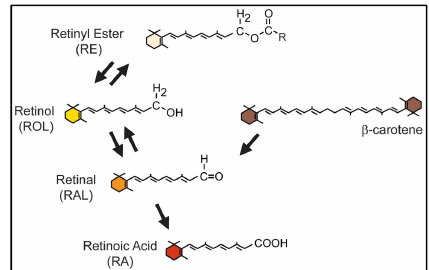
Figure 1. Retinoid compounds differ with respect to the polar end group at the terminus of the chain. The compound all- trans -retinol (ROL) can be reversibly converted to all- trans -retinal (RAL) or to retinyl esters (RE). The carotenoid β -carotene can be converted to RAL. RAL can be irreversibly oxidized to retinoic acid